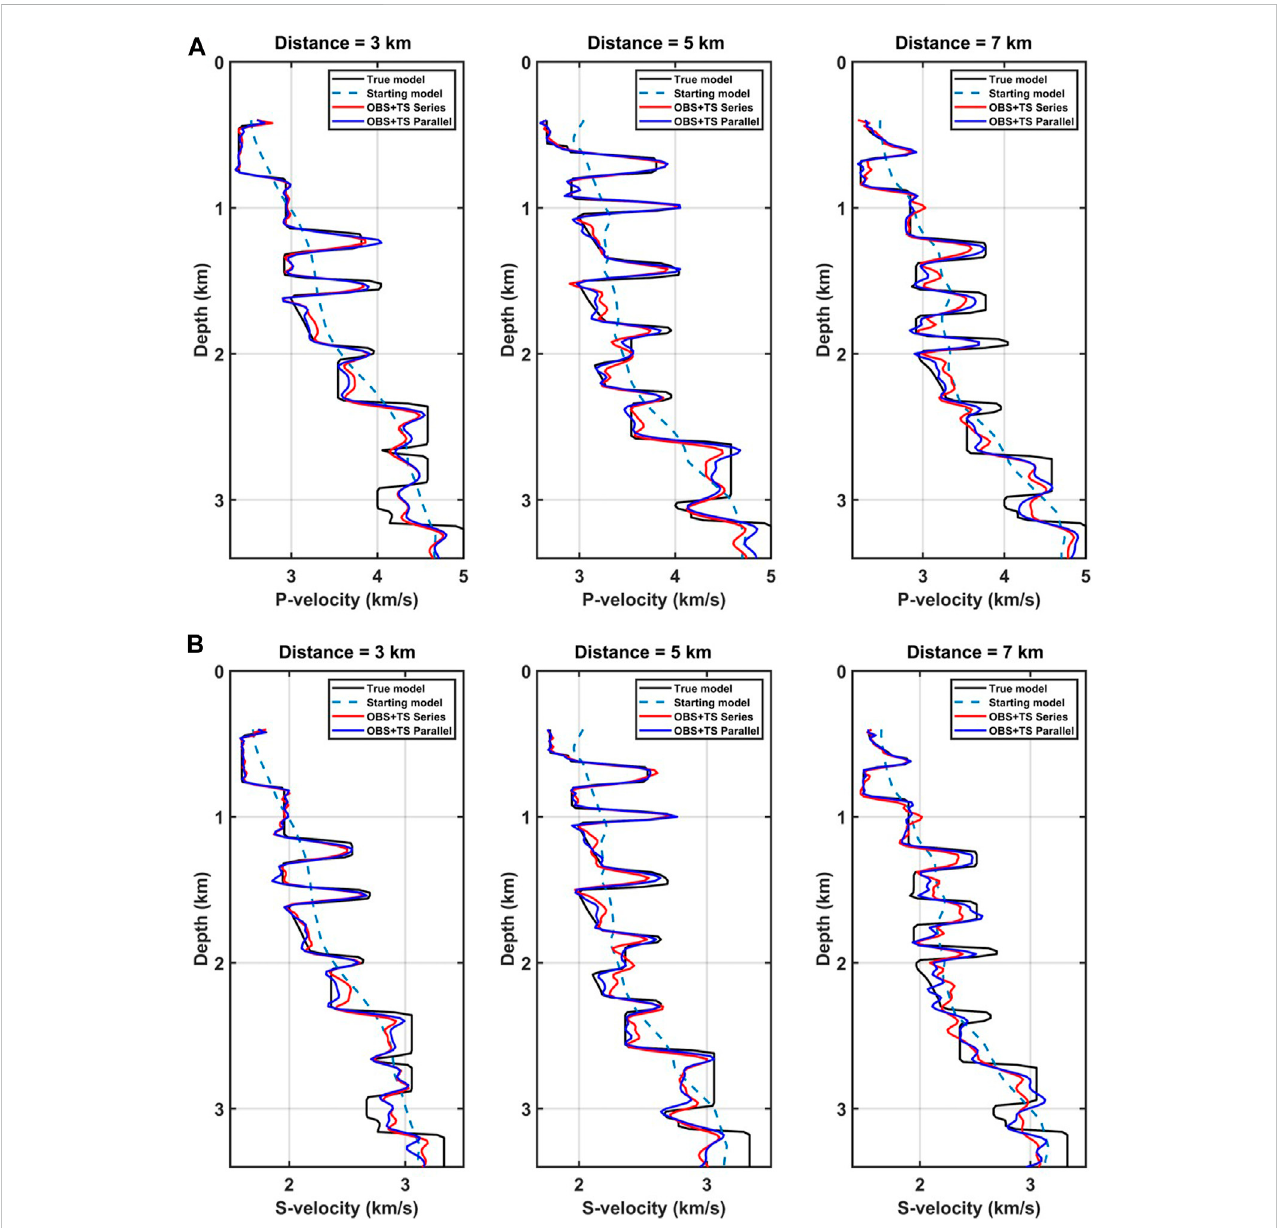
Vertical P-wave velocity (A) and S-wave velocity (B) pro fi les at three different locations. The solid black lines indicate the true velocities, the dashed lines indicate the starting velocities, the red lines indicate the cascaded AEFWI results, and the blue lines indicate the J-AEFWI